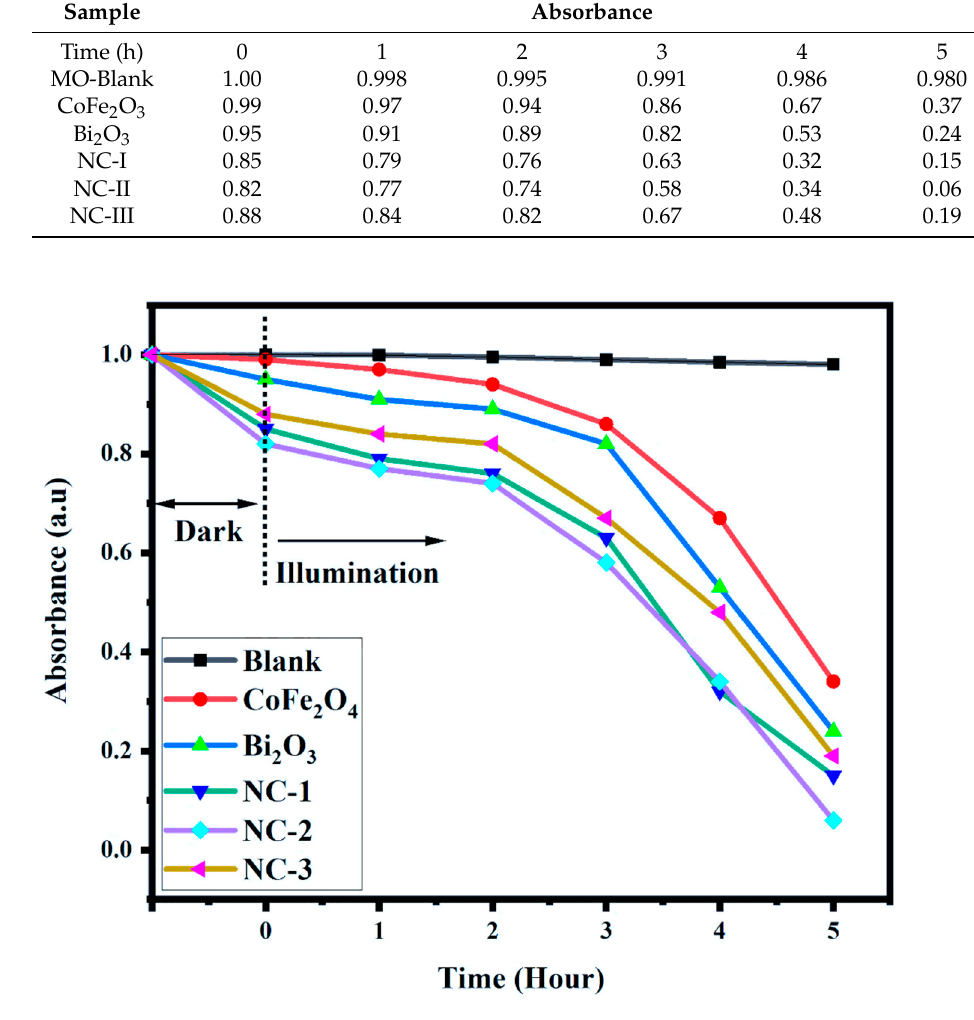
Figure 4. Absorbance of dye solutions charged by various as-prepared photocatalysts during pho- todegradation experiment.